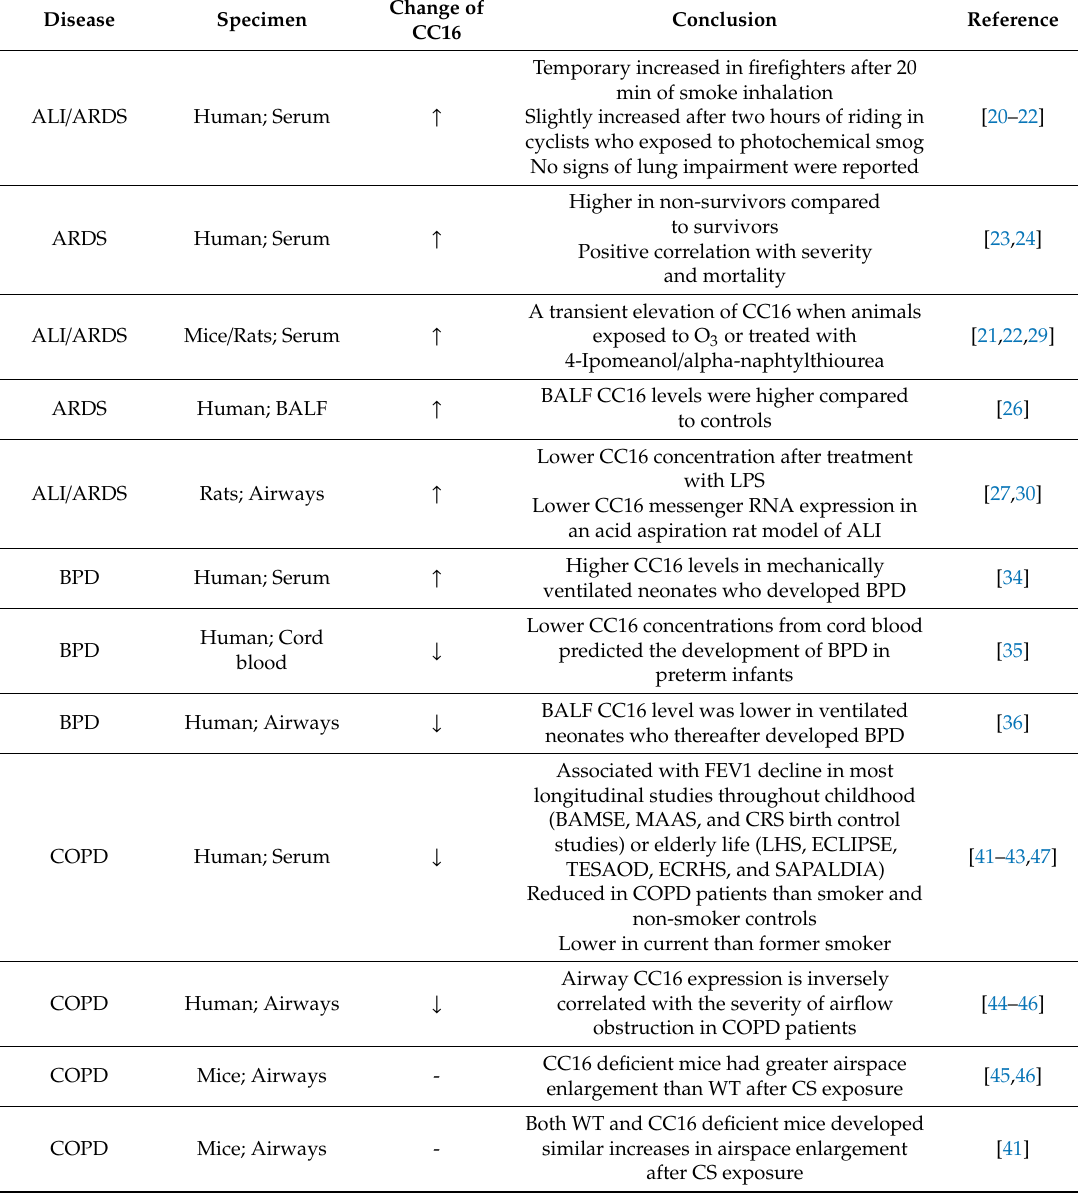
Table 1. The Changes of CC16 in pulmonary